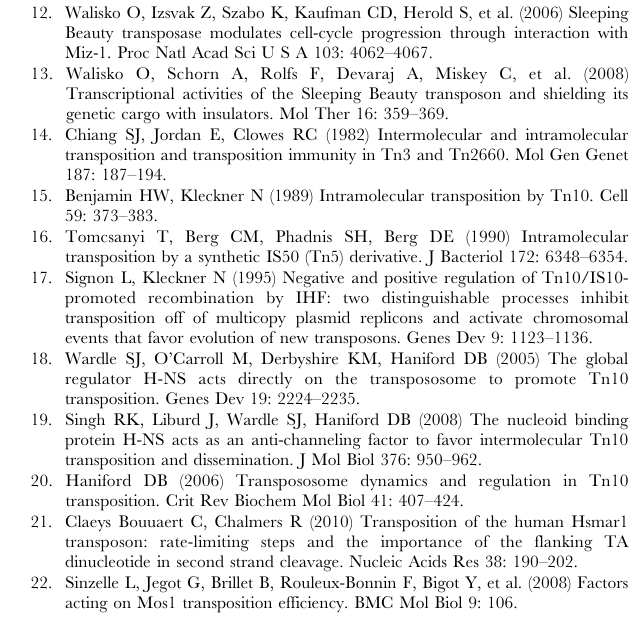
Figure S3 Knockdown of BAF1 by RNA interference. The knock-down effect of the RNAi approach [88] used against BANF1 monitored by Western blotting (25 m g of total cell lysates). Actin was to monitor for equal loading. Figure S4 The cellular factor, HMGB1 does not affect SB autointegration. Relative autointegration frequencies of SB ( SB7K ) in HeLa cells, where HMGB1 was either knocked-out [60] (HMG-) or overexpressed (cHMG). No significant effect was detected in either case when compared to the wild type